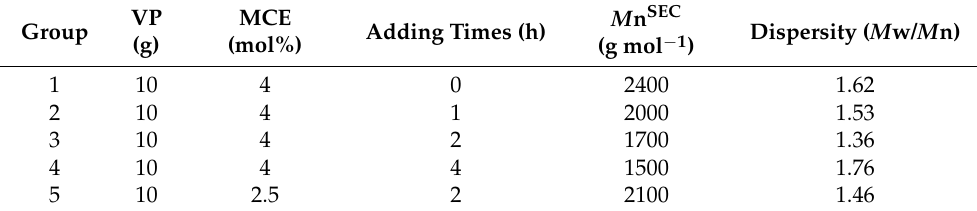
Figure 1. The synthesis process of PVP- b -P(St/ITA). Table 1. PVP-OH molecular weights with different mercaptans and dropwise adding times.